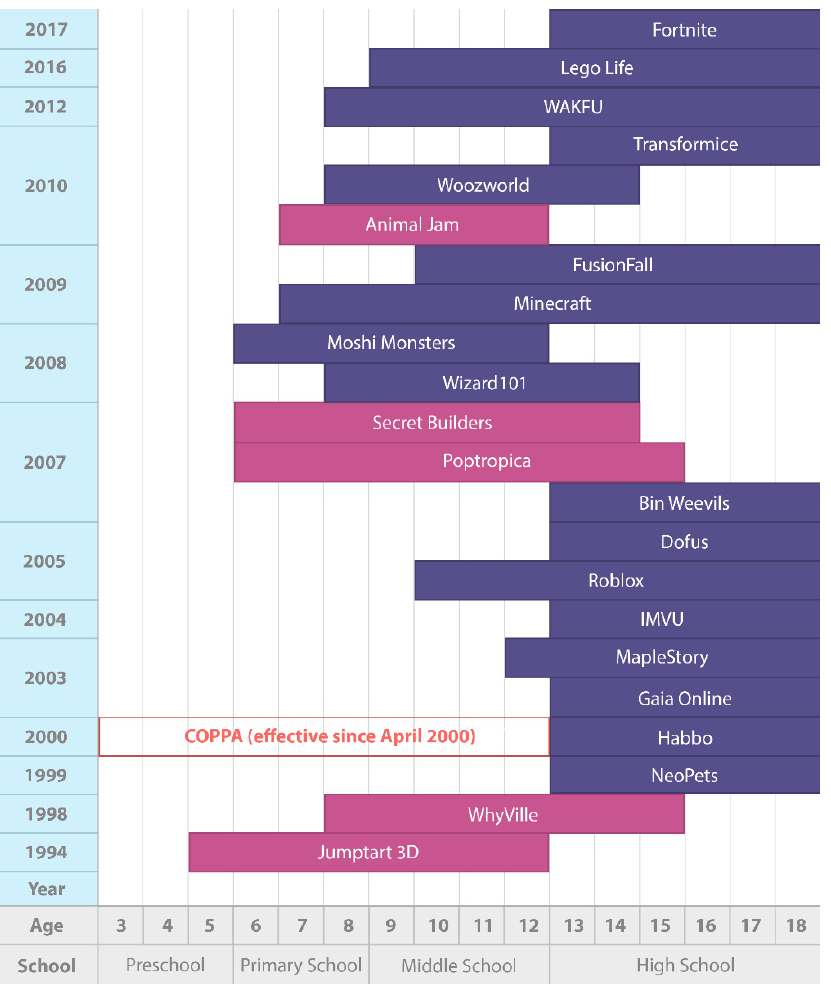
Figure 1. Historical overview of selected platforms by target player age range and platform initial launch year. Pink denotes platforms developed by ed-tech technology companies, and purple denotes entertainment technology companies.